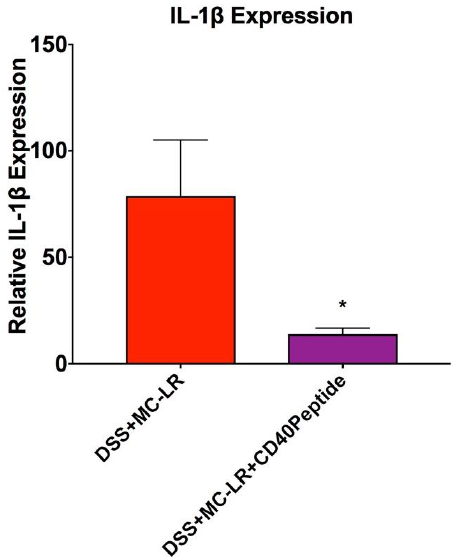
Figure 9. RT-qPCR analysis of pro-inflammatory cytokine IL-1β. Data presented indicate the mean ± SEM ( n = 4–11 mice per group). * p < 0.05